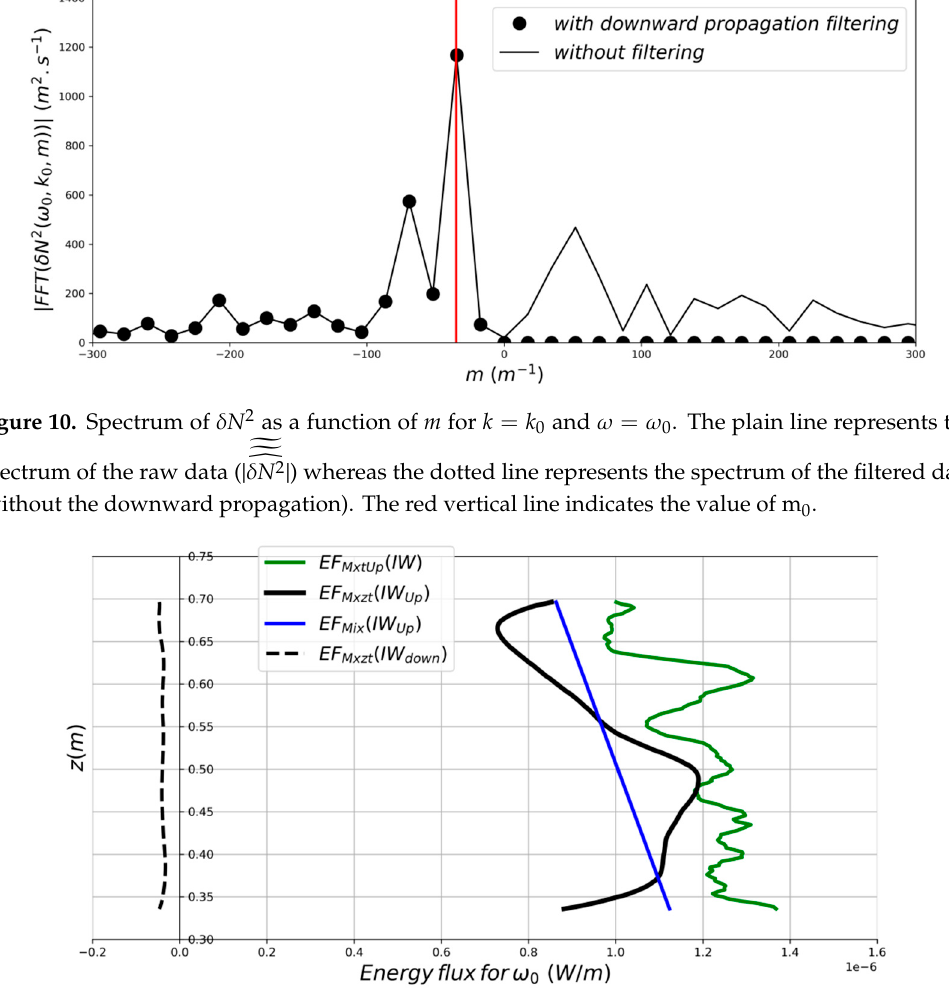
Figure 11. Upward (plain curves) and downward (dashed curve, only for the Mxzt method) energy flux resulting from the MxtUp (green curve) and Mxzt (black curve) methods, associated with the fundamental frequency ω 0. The blue line represents a mixed solution for the upward energy flux constructed from the mean slope of the MxtUp solution and the mean of the Mxzt solution.